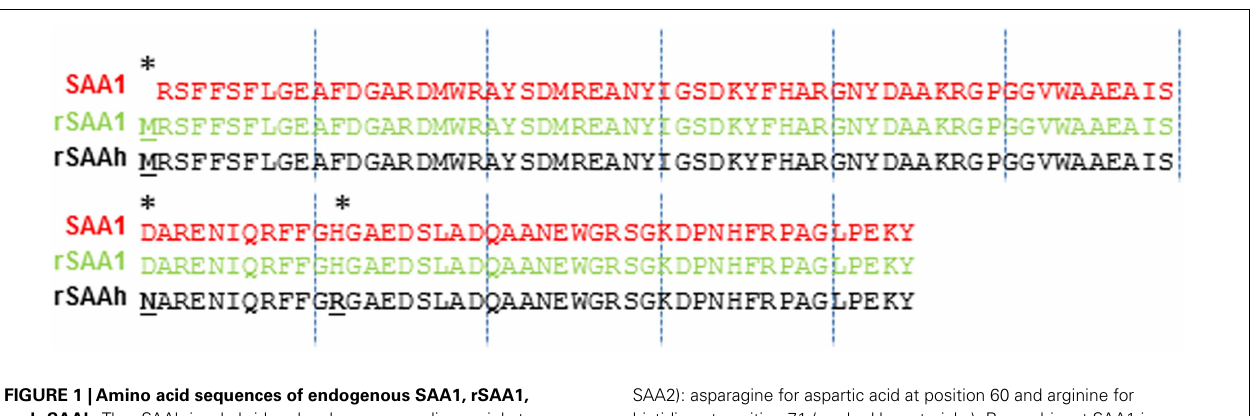
FIGURE 1 |Amino acid sequences of endogenous SAA1, rSAA1, and rSAAh .The rSAAh is a hybrid molecule corresponding mainly to human SAA1 with the exception of the presence of an N-terminal methionine and two substitutions (derived from the sequence of